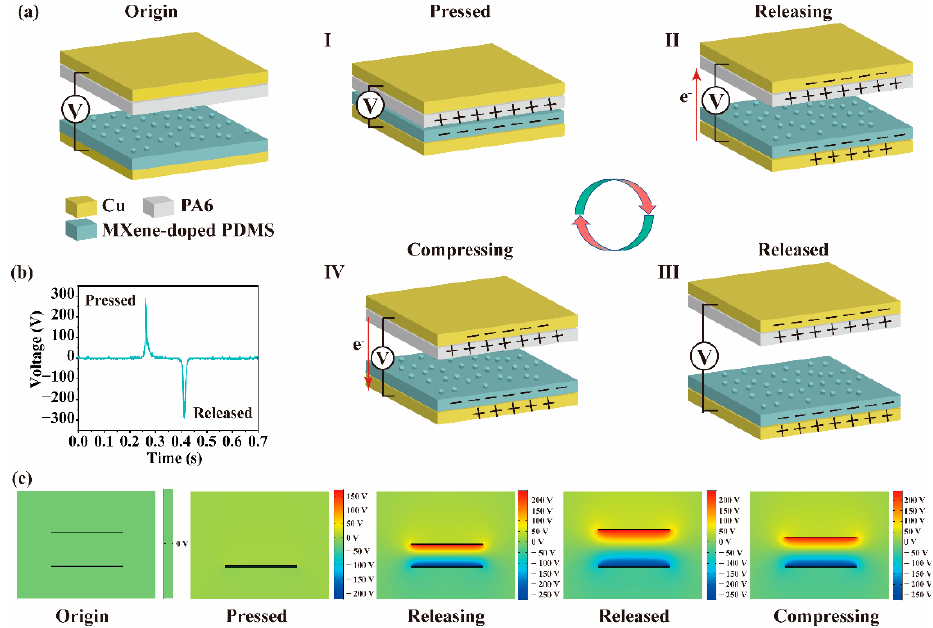
Figure 2. ( a ) Working principle of the LLB TENGs. ( b ) Voltage signal during one working cycle. ( c ) Simulation of potential distribution for one working cycle by COMSOL